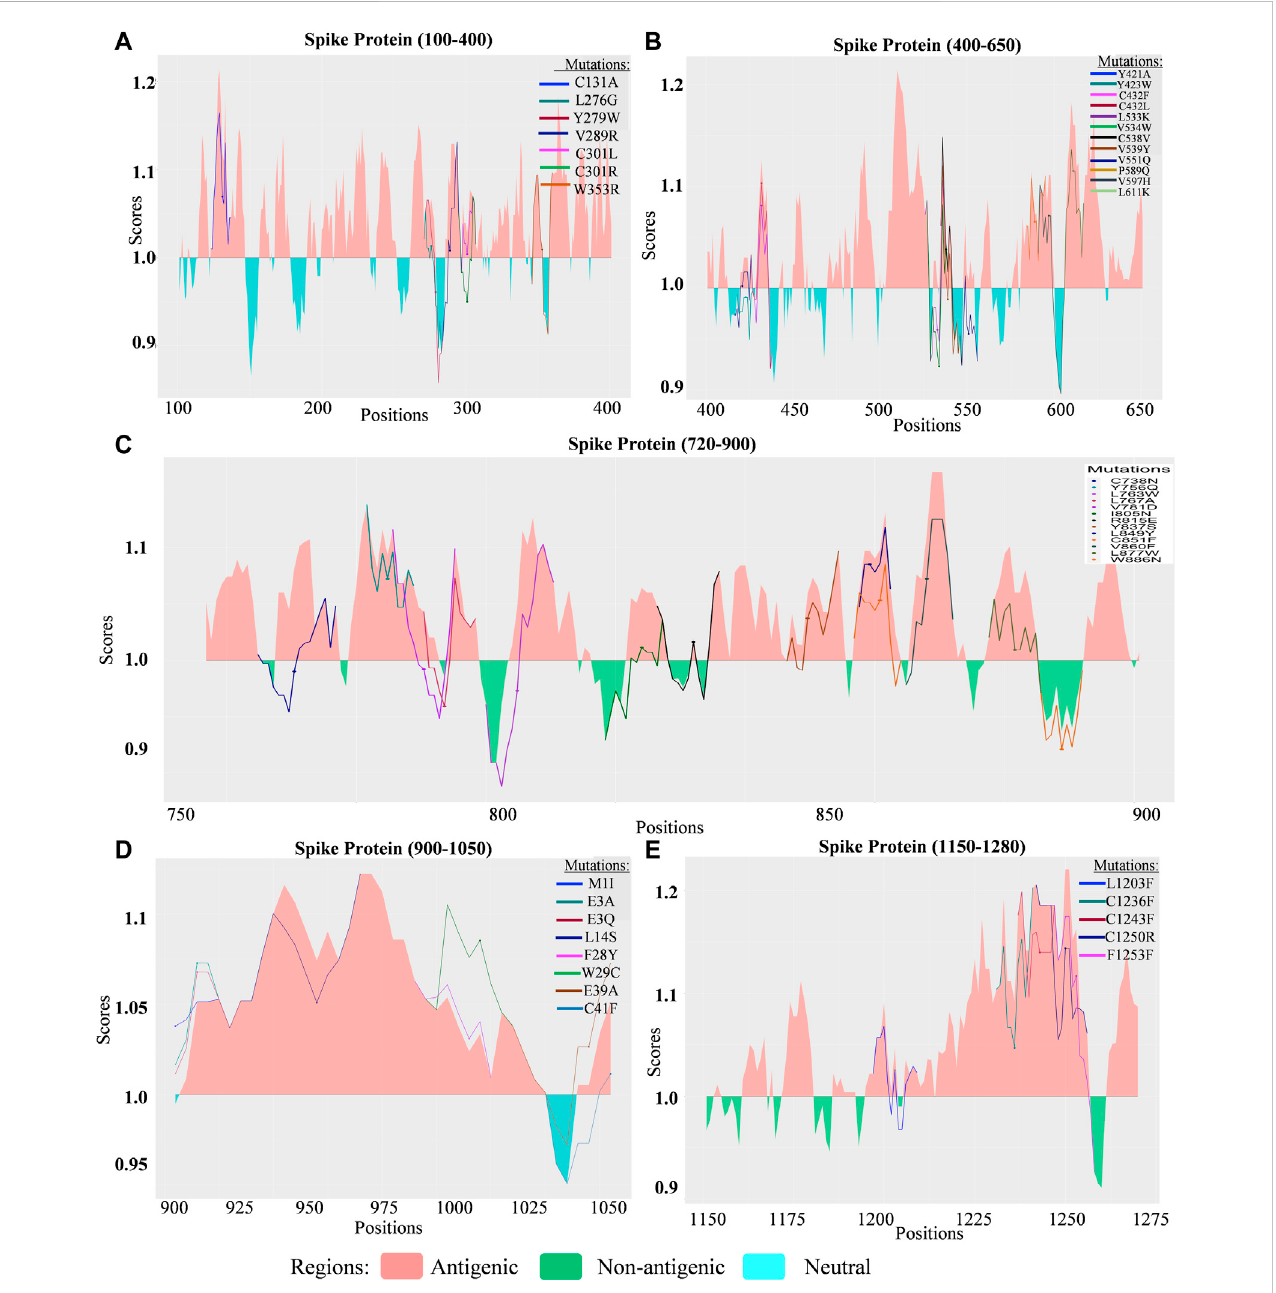
FIGURE 5 ComparisonoftheBcellepitopeforspike(S)proteinofSARS-CoV-2Deltavariant. (A) Bcellepitopepredictionscorefrom100to400aminoacids(aa)of the S protein. (B) B cell epitope prediction score from 400 to 650 aa of the S protein. (C) B cell epitope prediction score from 720 to 900 aa of S protein. (D) B cell epitope prediction score from 900 to 1050 aa of the S protein. (E) B cell epitope prediction score from 1150 to 1280 aa of the S protein.